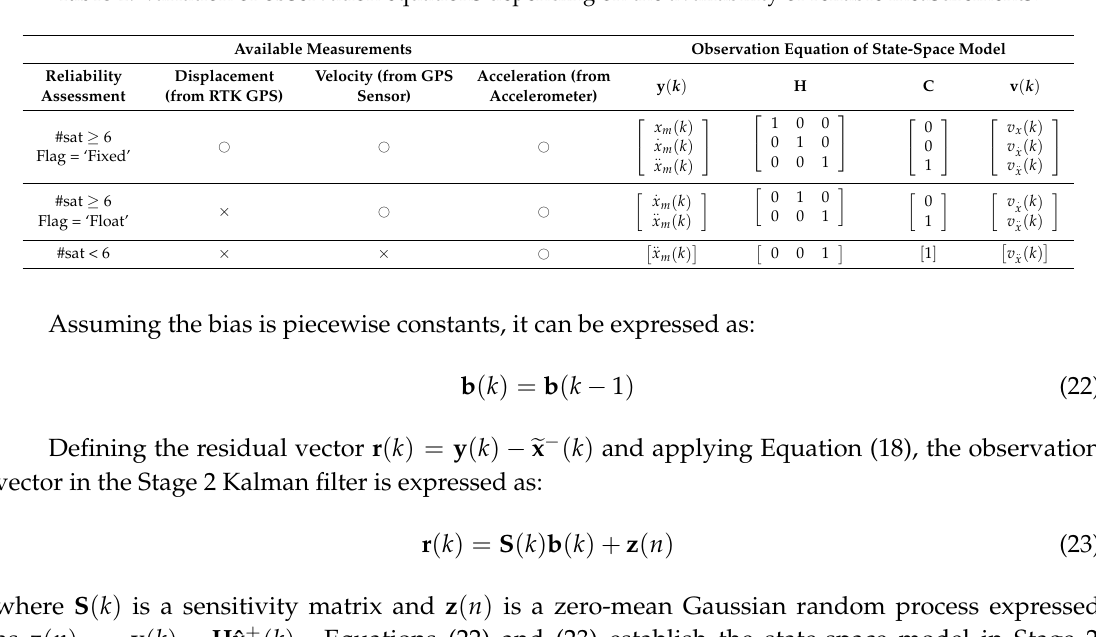
Table 1. Variation of observation equations depending on the availability of reliable measurements.